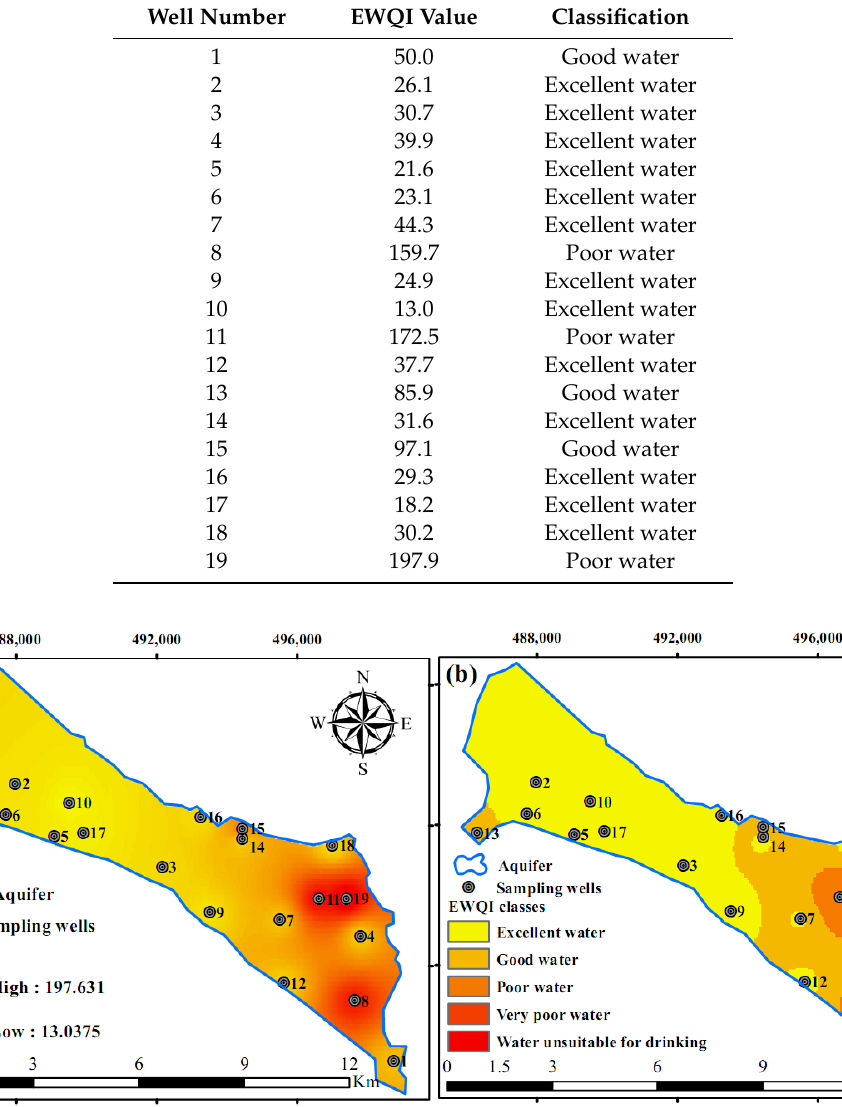
Figure 2. ( a ) Spatial distribution of EWQI score and ( b ) Classification of EWQI in the study